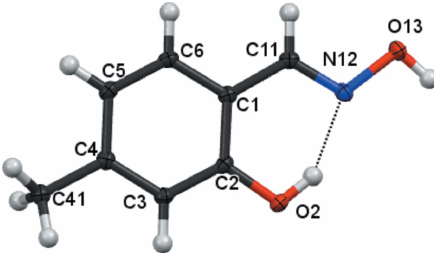
Figure 3 The molecular structure of compound 3 , showing 80% displacement ellipsoids.